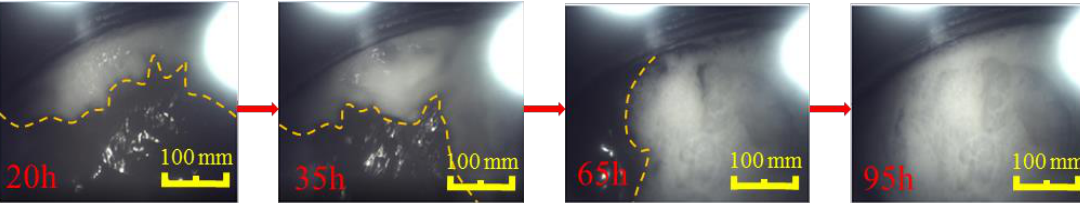
Figure 4. The preparation process of natural gas hydrate in stirring method. The yellow dotted line indicates the hydrate boundary. ( a ) In the first panel, The white flocculent is hydrate. The area of darker color in contact with hydrate is the prepared water. The white bright spot is the light of the fill light lamp. ( b ) In the second panel, The white flocculent is hydrate. The area of darker color in contact with hydrate is the prepared water. The white bright spot is the light of the fill light lamp. ( c ) In the third panel, The white flocculent is hydrate. The area of darker color in contact with hydrate is the prepared water. The white bright spot is the light of the fill light lamp. ( d ) In the fourth panel, The white flocculent is hydrate. The white bright spot is the light of the fill light lamp.